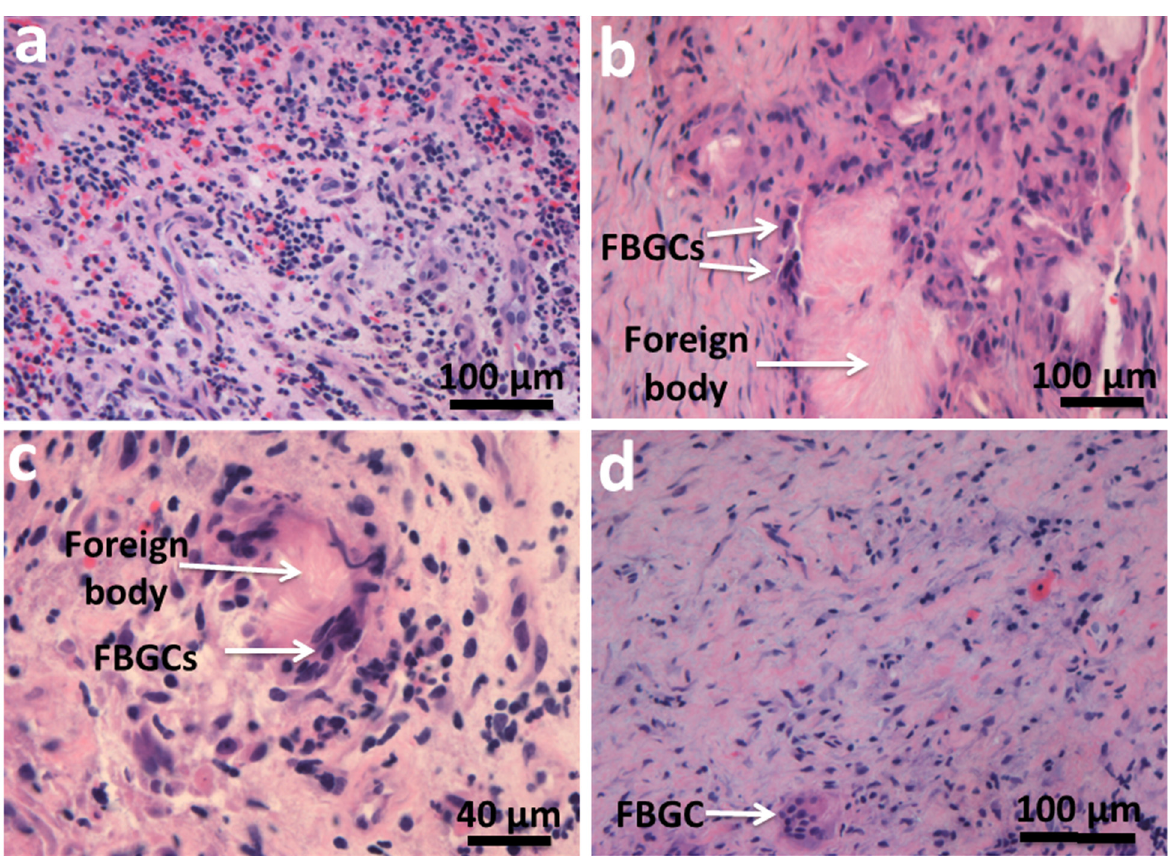
Figure 4. ( a ) Mixed acute and chronic inflammatory infiltrate; ( b , c ) FBGCs surrounding a foreign body; ( d ) Fibrous tissue and